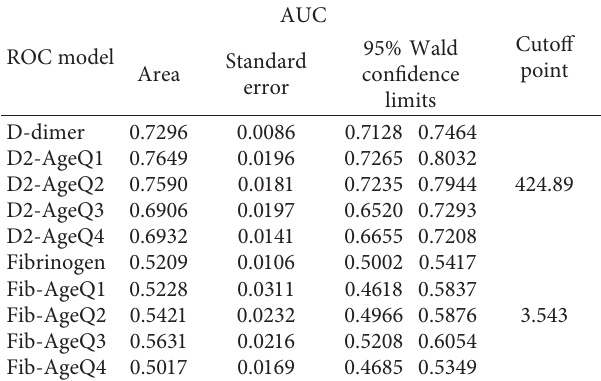
Figure 1: ROC curve for comparisons of D-dimer, fibrinogen, and combination of them in all patients. Table 3: The cutoff point and AUC of different ages.